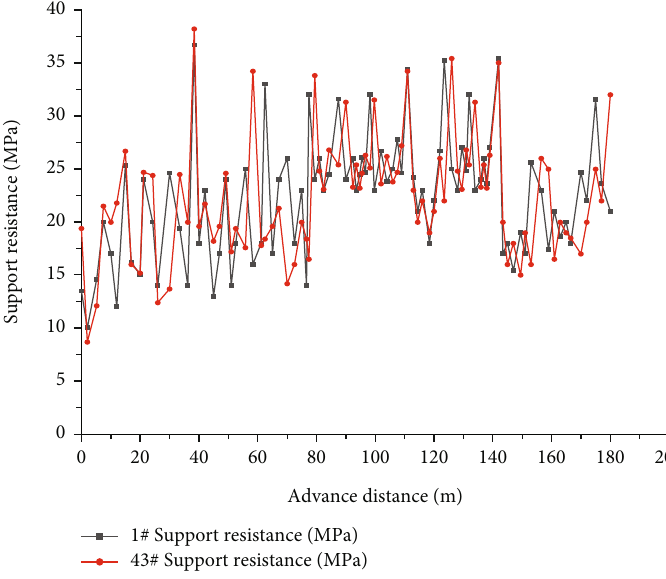
Figure 13: Working resistance curve of hydraulic support.